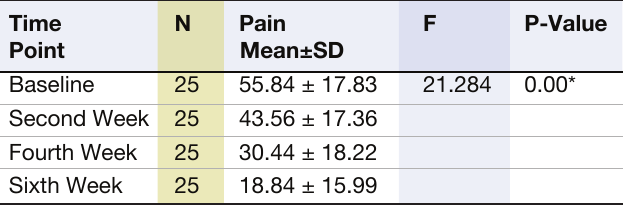
Table 4. Pain Intensity Scores of Participants in the Clinic Group across Baseline, Second, Fourth and Sixth Week of Intervention